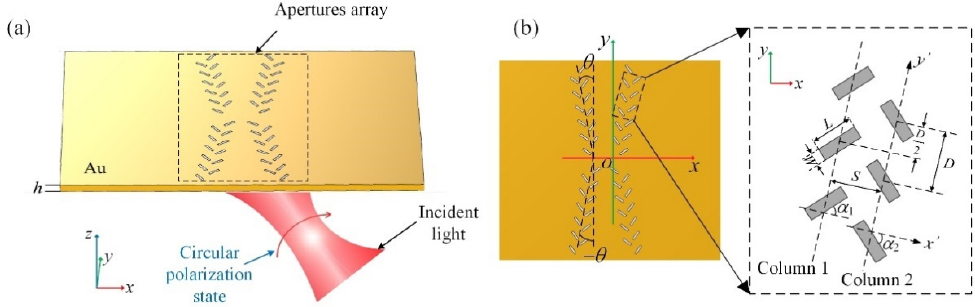
Figure 1. ( a ) The schematic diagram of tunable and spin-controlled nondiffracting SPP-beam directional launching device, in which a nano-rectangular slot array structure is etched on a gold film. ( b ) The schematic diagram of the rectangle slot array and its parameters. The width and length of the nano-rectangular slot are W and L .